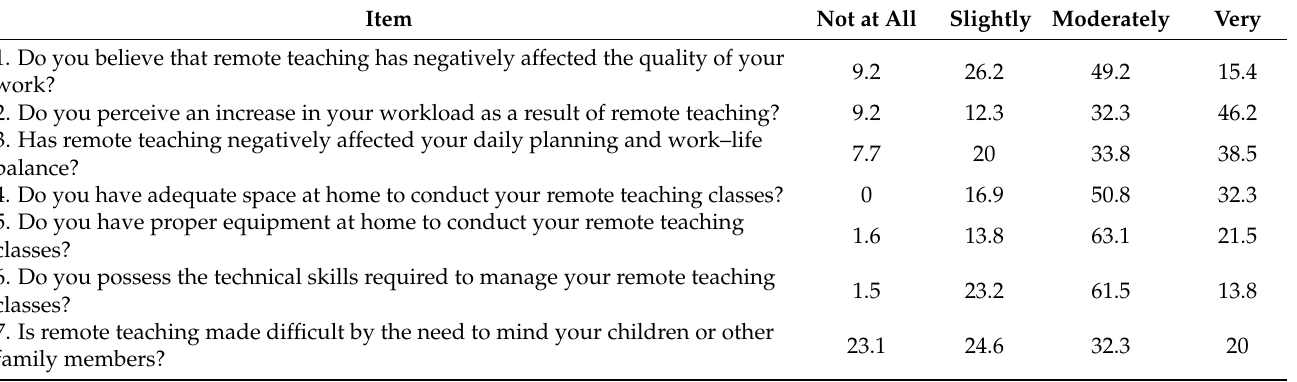
Table 1. Percent frequency distribution of teachers’ answers to the remote teaching